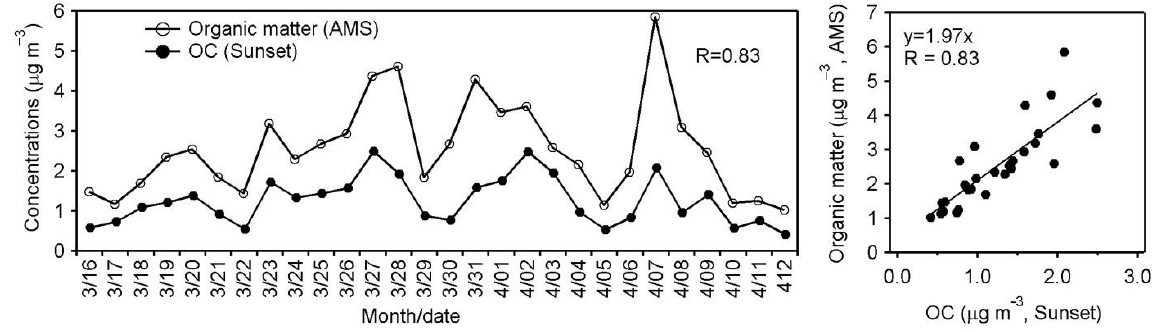
Figure 6. Temporal variations of organic matter (OM) measured by AMS and organic carbon (OC) measured by Sunset Laboratory carbon analyzer ( left panel) and correlation plots ( right panel) between OC and organic matter measured by two instruments (Sunset and AMS) in aerosols collected from Cape Hedo, Okinawa.